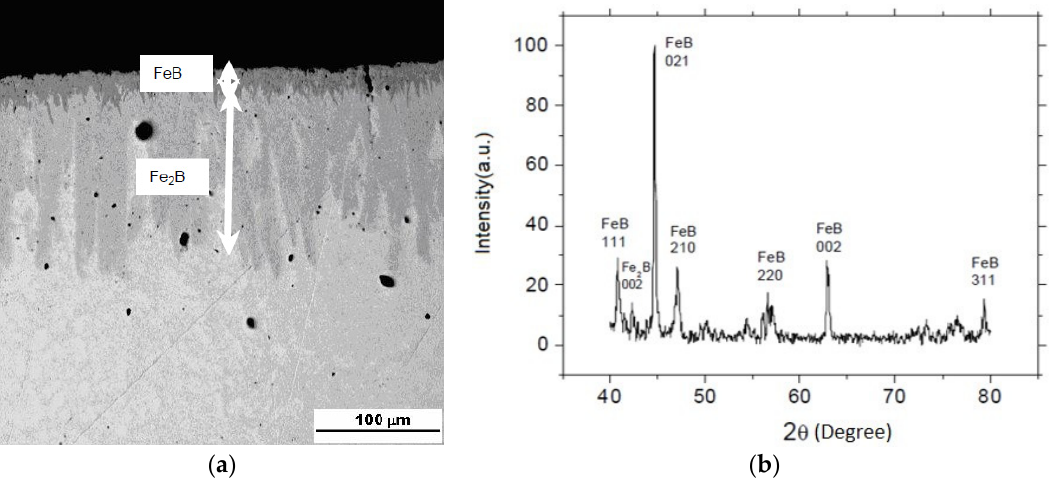
Figure 6. The controlled boride multilayer growth: ( a ) Scanning electron microscopy (SEM) image and ( b ) X-ray diffraction analysis.